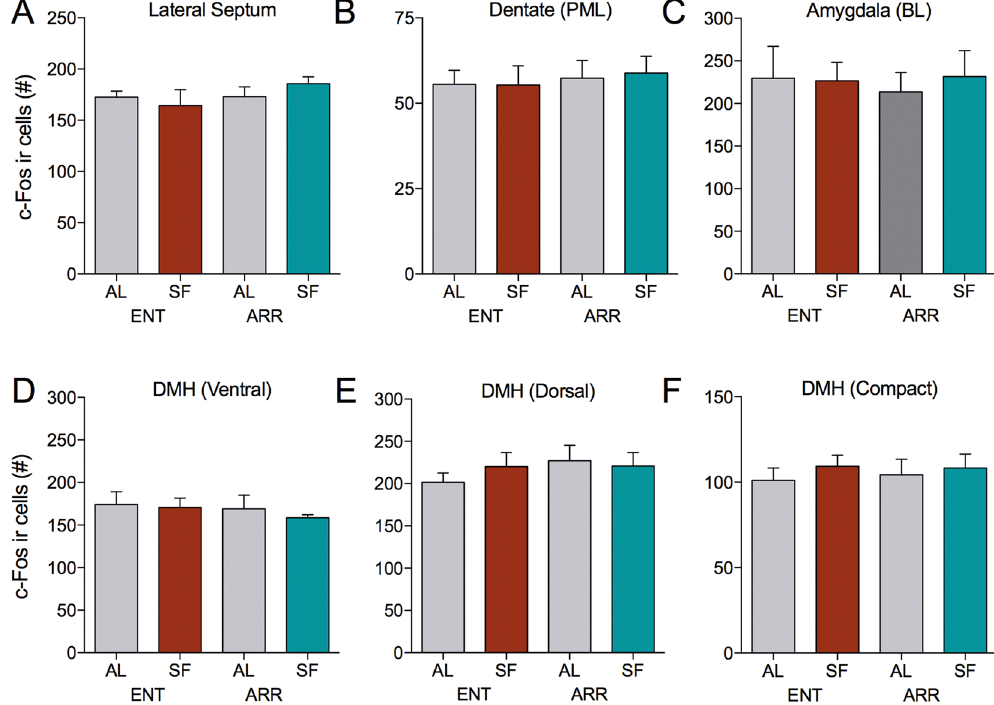
Figure 5. SF had no effect on c-Fos expression in these brain regions. ( A ) lateral septum, ( B ) polymorphic layer of the dentate gyrus, ( C ) basolateral nucleus of the amygdala, ( D ) ventral region of the dorsomedial hypothalamic nucleus (DMH), or ( E ) dorsal region of the DMH, and ( F ) compact nucleus of the